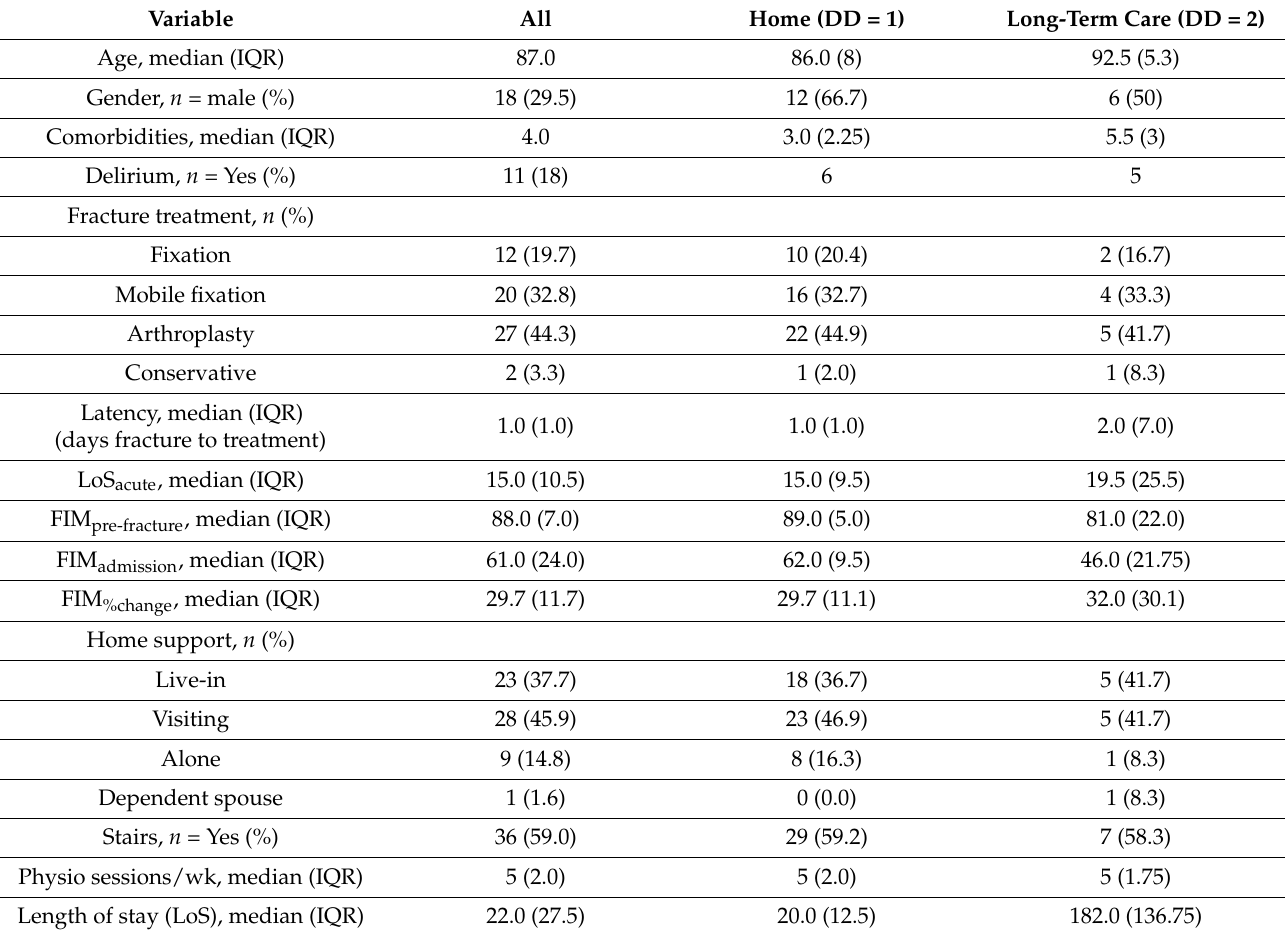
Table 1. Characteristics of study